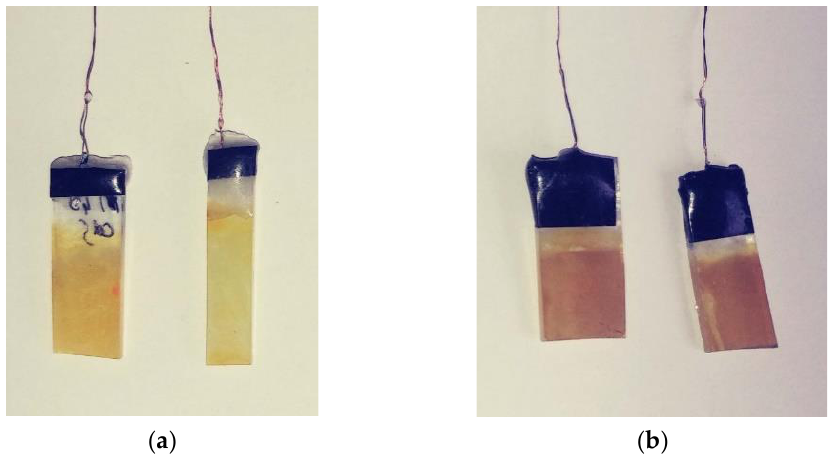
Figure 6. Photographic image of the anodes made before and after the PEC reaction: ( a ) 1D ZnO/CdS;